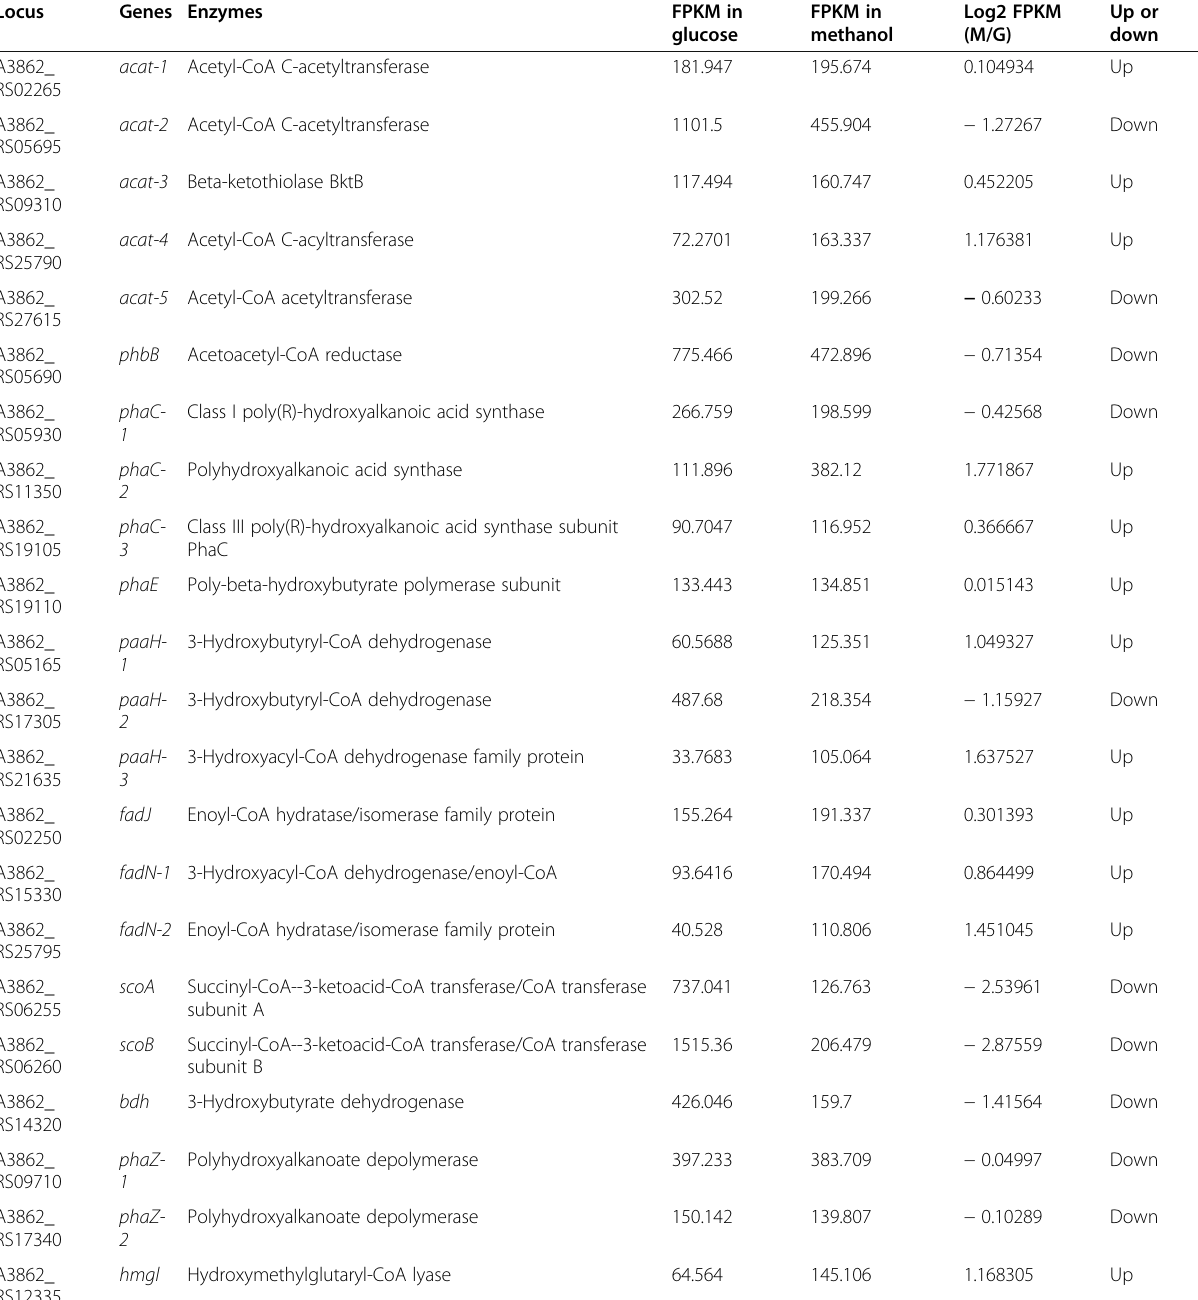
Table 4 FPKM values of PHB synthesis-related genes based on RNA-seq analysis Locus Genes Enzymes FPKM in